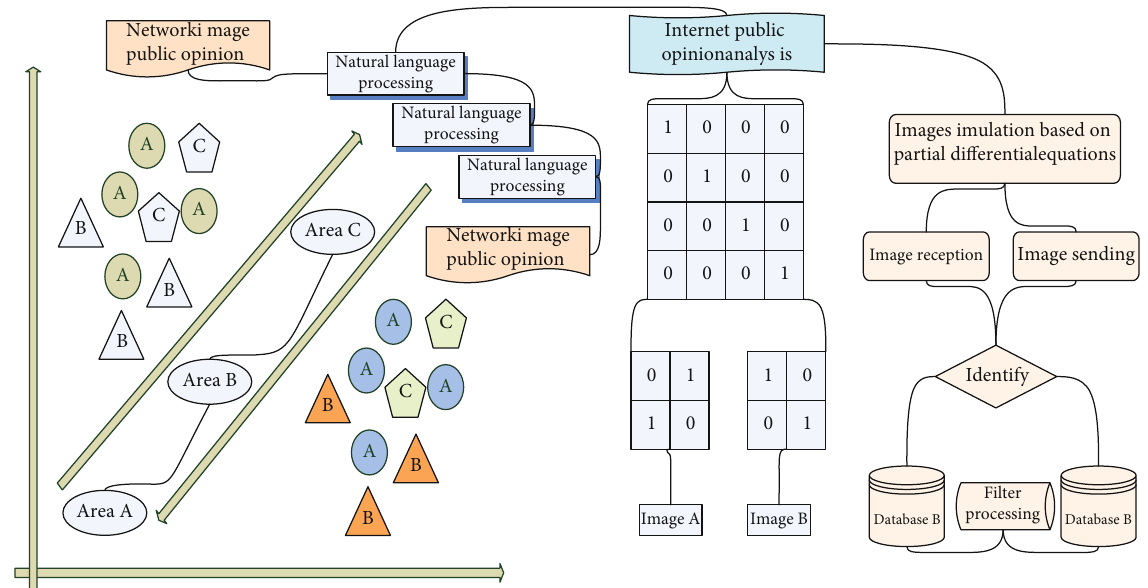
Figure 2: Schematic diagram of network image